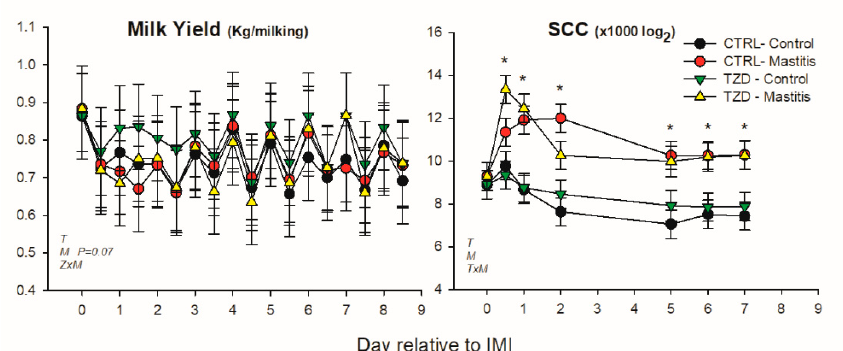
Figure 2. Effect on milk yield and somatic cell count (SCC) of a daily injection of 2,4-thiazolidinedione (TZD) and saline (CTR) in Saanen dairy goats plus intramammary infusion in the right half of the mammary gland with Strep. uberis (IMI) while the left half of the mammary was left untouched (control). Overall statistical significance ( p ≤ 0.05) is indicated in the plot as follows: T = time effect; M = IMI effect; Z = effect of 2,4-thiazolidinedione injection. When a significant ( p ≤ 0.05) interaction was present for T × M, the difference between groups at each time point is denoted by *. Vet. Sci. 2019 , 6 , x